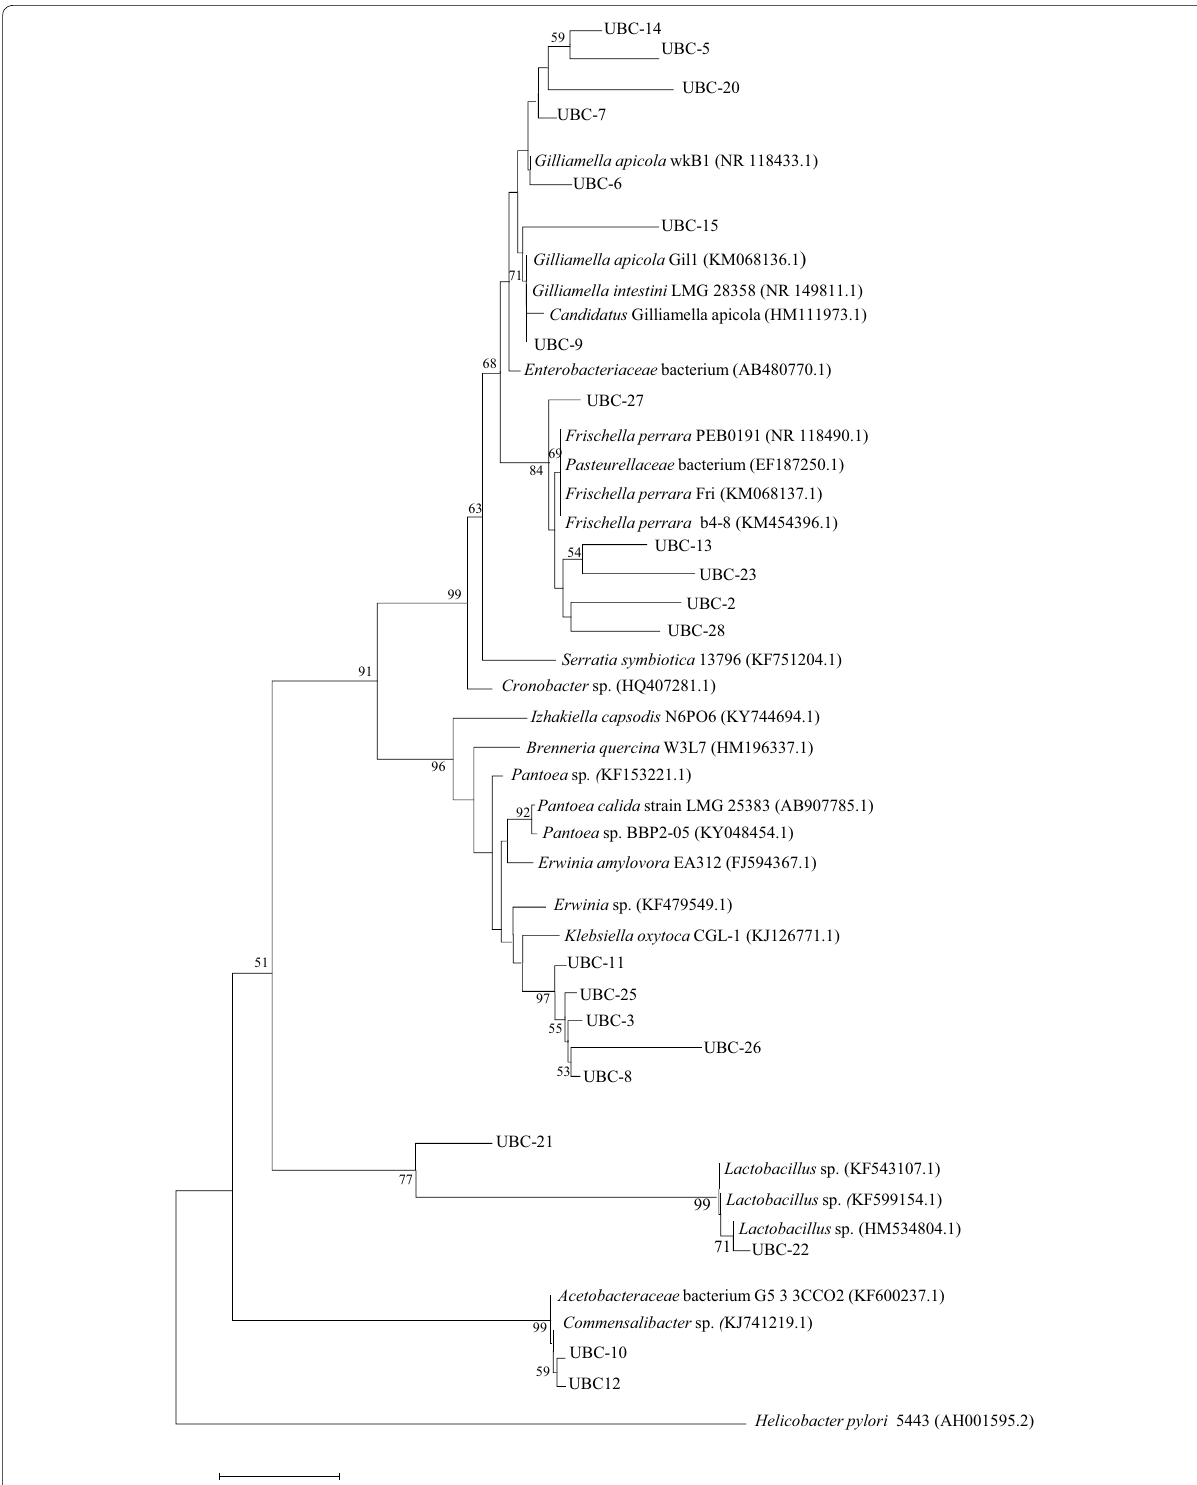
Fig. 2 Phylogenetic tree of the gut microbial clones of the unexposed bees. The evolutionary history was inferred using the neighbor‑joining method and the evolutionary distances were computed using the Kimura‑2 parameter. The percentage of replicate trees in which the associated taxa clustered together in the bootstrap test (1000 replicates) is shown next to the